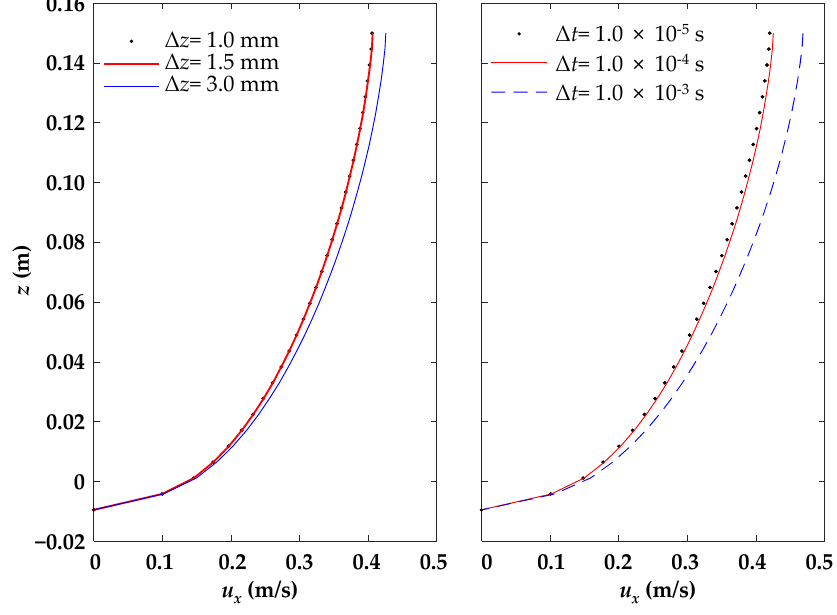
Figure 3. Grid size and time step convergence.